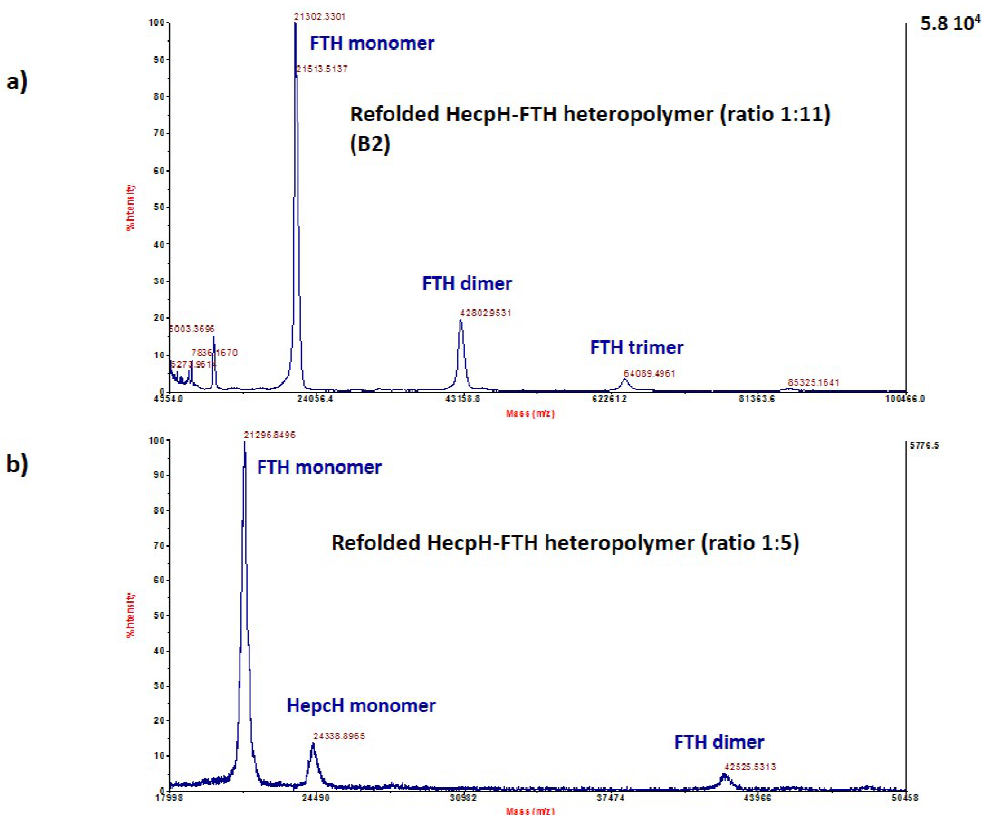
Figure 4. High-resolution MALDI-TOF mass analysis of the refolded HepcH-FTH heteropolymer. ( a ) MALDI-TOF mass analysis of the refolded HepcH-FTH heteropolymer, assembled using a molar ratio HepcH:FTH of 1:11, showing masses corresponding to FTH monomers, dimer and trimer. ( b ) MALDI-TOF mass analysis of the refolded HepcH-FTH heteropolymer, assembled using a molar ratio HepcH:FTH of 1:5, showing masses corresponding to HepcH and FTH monomers and FTH dimer.